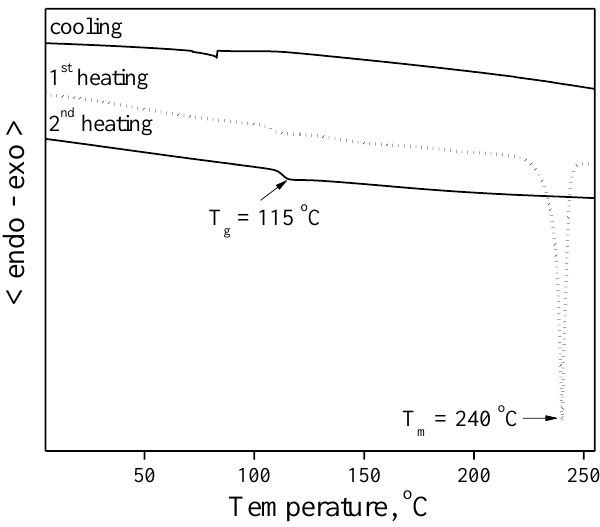
Figure 3. DSC curves of material 4 . Heating rate was 10 °C/min.